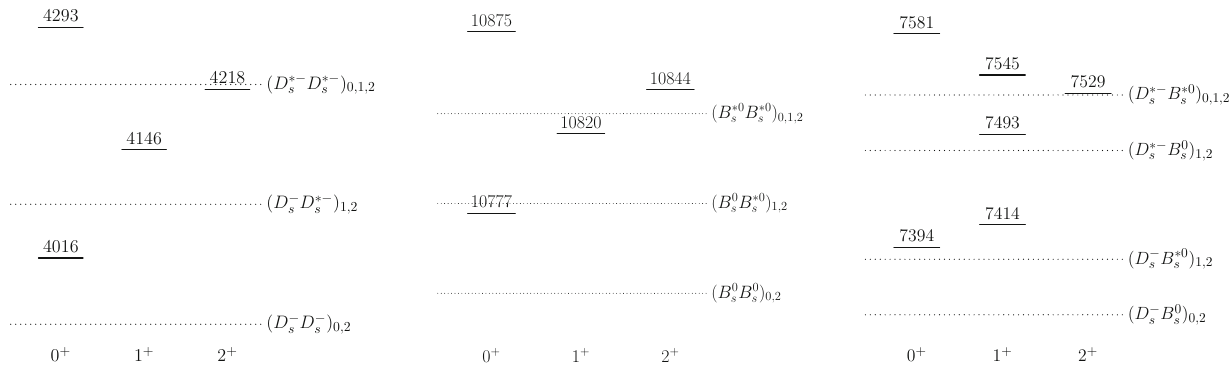
Fig. 4 Theestimatedmasses(units:MeV)ofthe ss ¯ c ¯ c (left), ss ¯ b ¯ b (mid- a tetraquark is equal to a subscript of the symbol for a meson–meson dle), and ss ¯ c ¯ b (right) systems in the threshold scheme. The dotted lines channel, the corresponding S - or D -wave decay is allowed are thresholds of the possible decay channels. When the total spin of ¯ ¯ ¯ ¯ ¯ b , ns ¯ c b , ss ¯ c ¯ c , ss b b , and ss ¯ c b systems. also valid for the nn ¯ c ¯ ¯ ¯ ¯ b b , ns ¯ c ¯ c , and ns b b cases, now the In the nn ¯ c ¯ c , nn